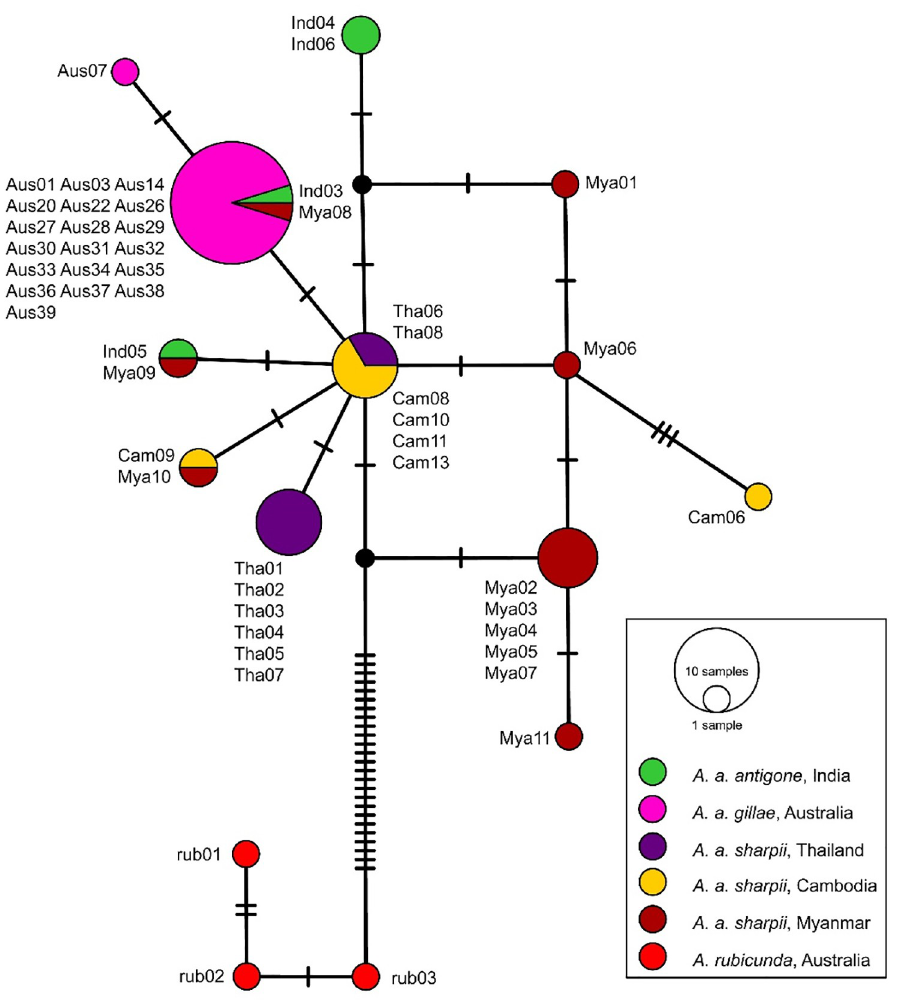
Fig 5. TCS network for five populations of the Sarus Crane A . antigone based on mtDNA sequences compared to the Brolga A . rubicunda (for sample codes see Table 2).